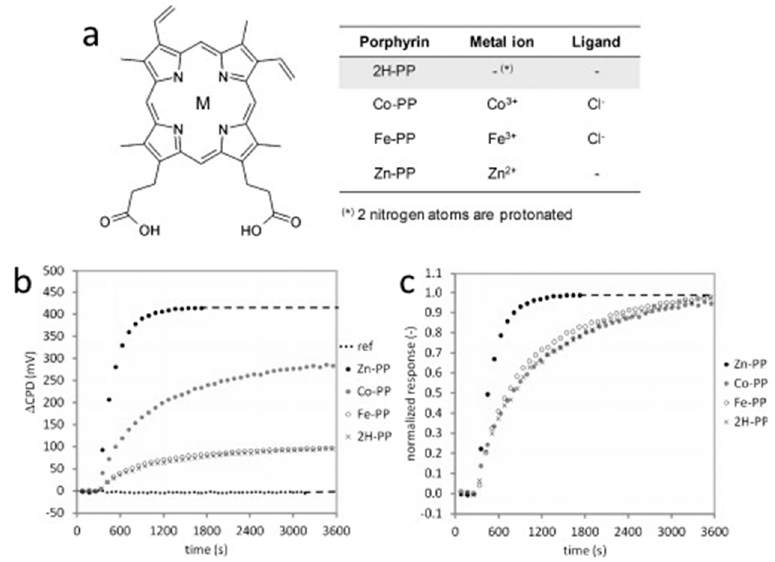
Figure 21. ( a ) Molecular structure of the used protoporphyrins IX. M indicates the position of the metal ion. ( b ) Kelvin probe response of the different porphyrins to 2 ppm NO; ( c ) same as ( a ), normalized to the equilibrium response. Adapted with permission from [99]. Copyright 2012 Elsevier.